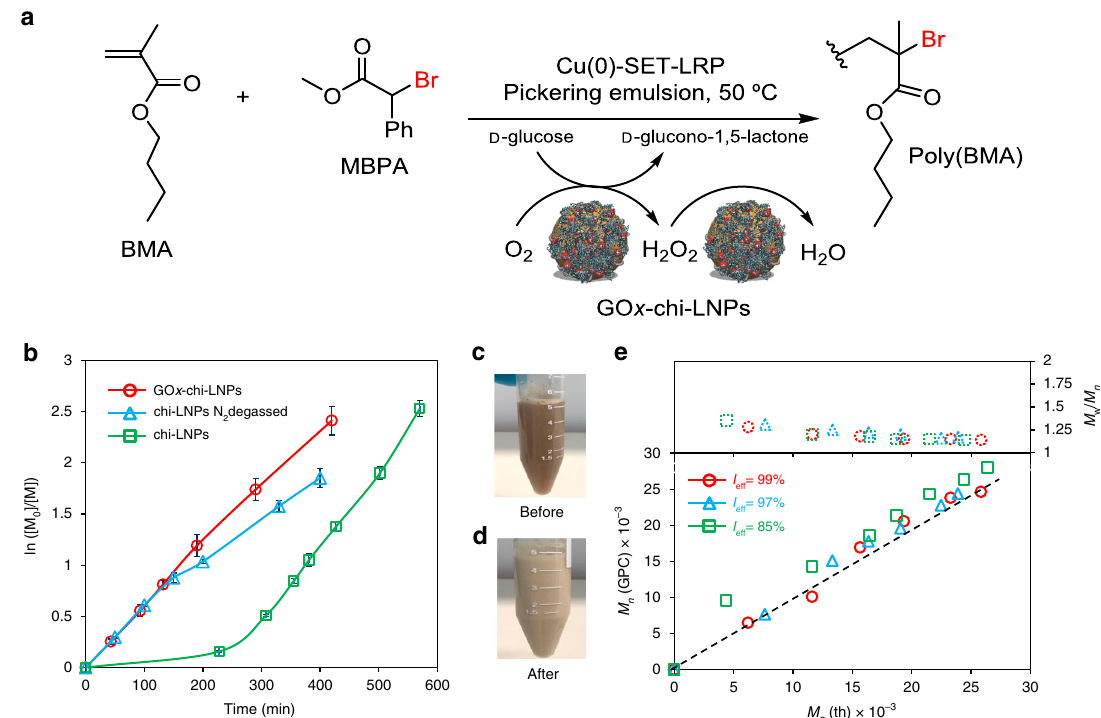
Fig. 3 Evaluation of the enzyme-degassed controlled radical polymerization of BMA using GOx-chi-LNPs as stabilizers. a Scheme of enzymatic- degassed SET-LRP-mediated Pickering emulsion of BMA. b Kinetic plots and e evolution of experimental M n (GPC) and M n / M w vs theoretical M n (th) for the SET-LRP-mediated Pickering emulsion of BMA using GOx-chi-LNPs (red circles), chi-LNPs (blue triangles) in the presence of oxygen, and chi- LNPs (green squares) in N 2 degassed emulsion. Mean values± SD ( n = 2) are shown in b , whereas all data points are shown in e . c , d Digital images of BMA-based Pickering emulsions before c and after d SET-LRP process using GOx-chi-LNPs as stabilizers. Reaction conditions: [BMA] 0 /[MBPA] 0 / [Me 6 -TREN] 0 /[Cu(0)] 0 = 200/1/0.2/0.3. [Lignin nanoparticles] = 2.25 wt% relative to